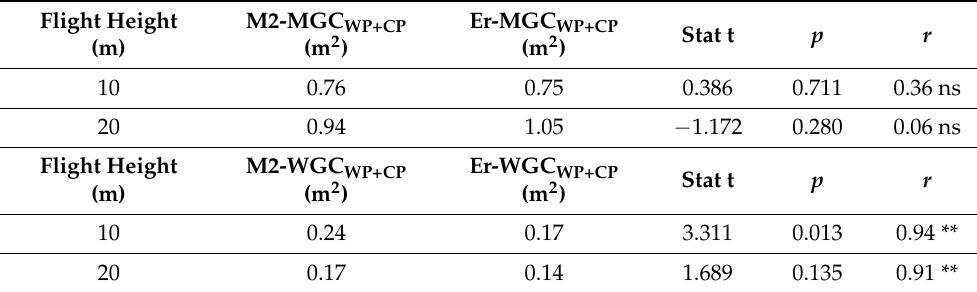
Table 4. Maize green cover and weed green cover in weeded and control plots (WP and CP) obtained using method 1 (M2-MGC WP+CP and M2-WGC WP+CP ) and Erdas (Er-MGC WP+CP and Er-WGC WP+CP ) (Student t -test). Flight Height